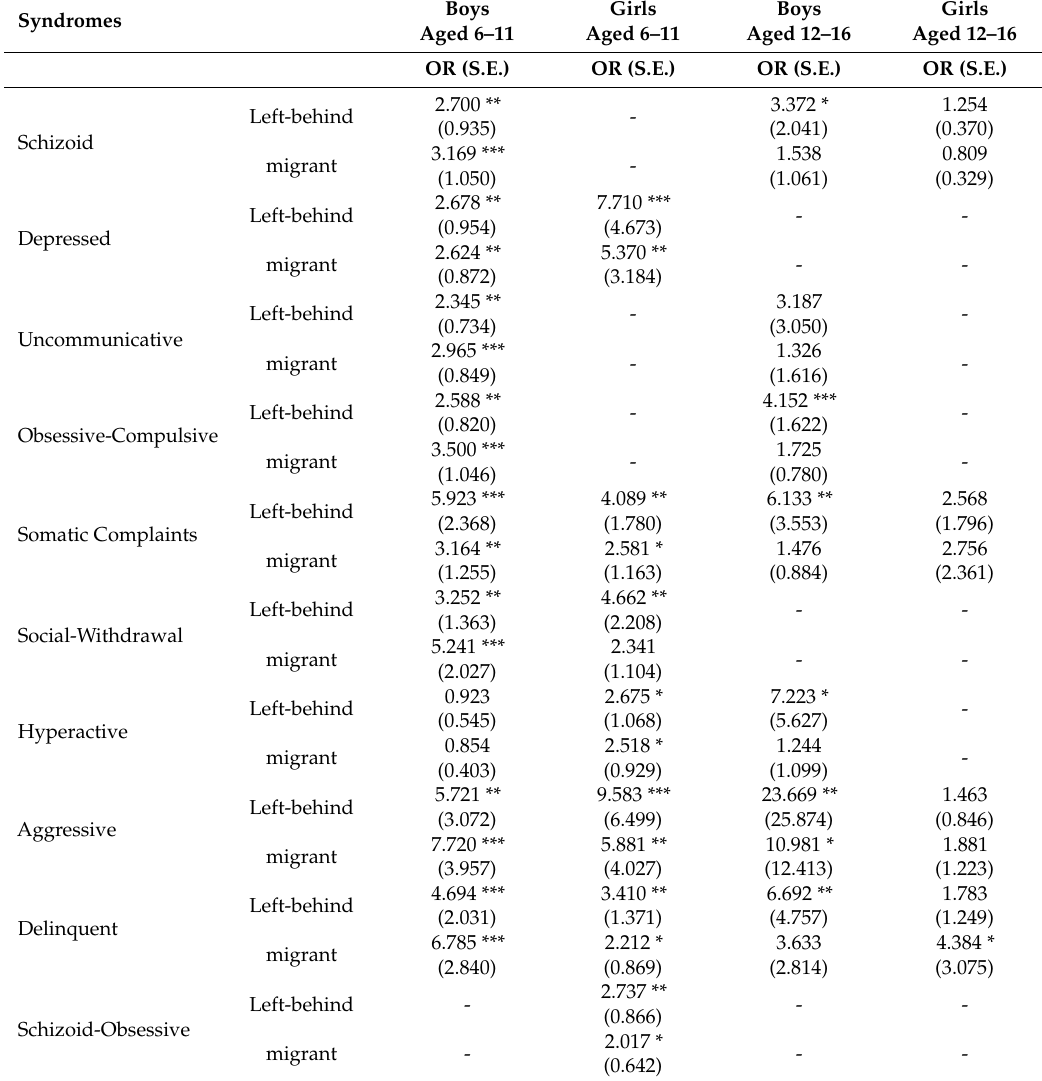
Table 6. Regression findings: specific syndromes of behavioral